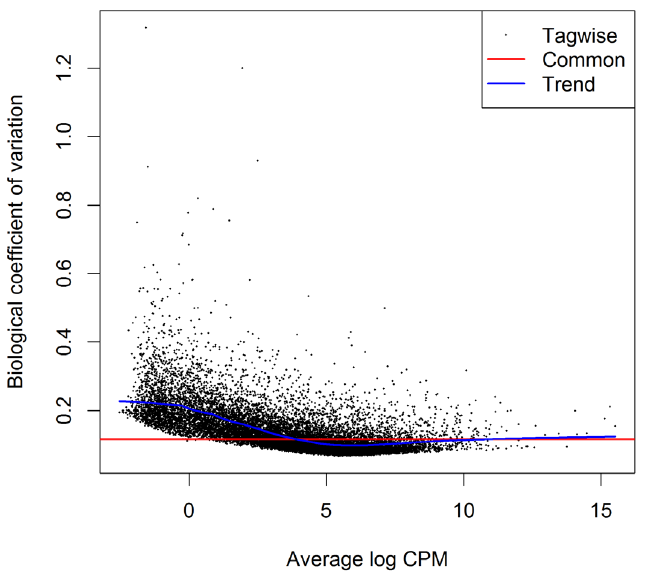
Figure 4. Scatterplot of the biological coefficient of variation (BCV) against the average abundance of each gene. The plot shows the square-root estimates of the common, trended and tagwise NB